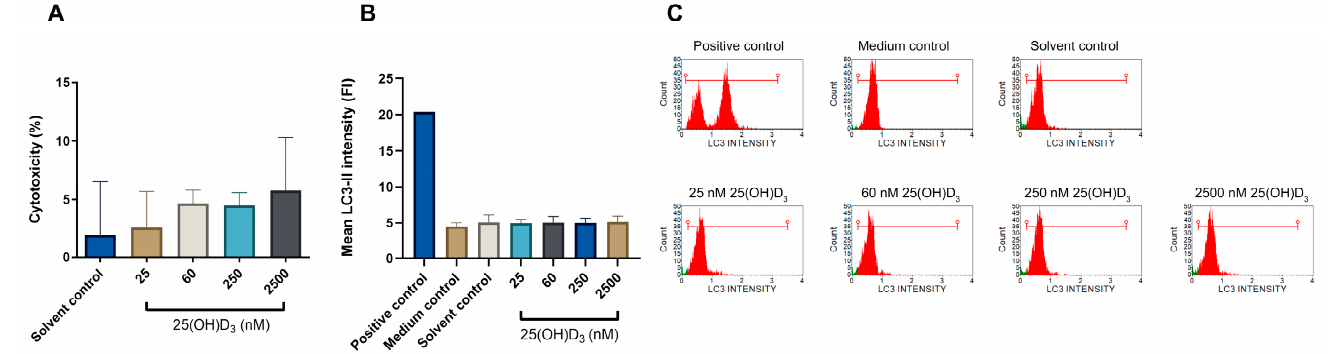
Figure 7. Evaluation of necrosis by the LDH release cytotoxicity assay, and measurement of autophagic-dependent cell death by LC3-II flow cytometric analysis in SiHa control and experimental cultures. Cytotoxicity was measured by the LDH release assay in control and experimental cultures ( A ). The y-axis identifies the percentage cytotoxicity, which indicates the activity of released intracellular LDH into the culture medium. Autophagic-dependent cell death by quantification of LC3-II is shown in bar graphs ( B ) and flow cytometric histograms ( C ) in the control and experimental SiHa cultures. Rapamycin (200 nM) was used to treat the positive control. All data are expressed as mean (±SEM) from three independent experiments, each performed in triplicate.